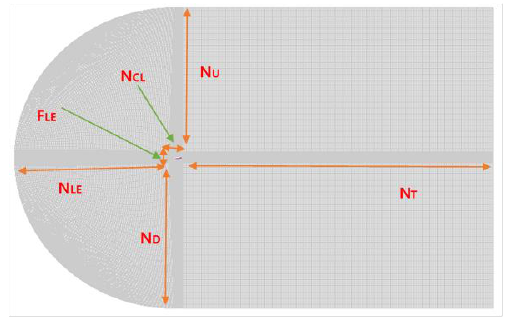
Figure 8. Mesh topology structure and its name. Table 4. Distribution of mesh in the computational domain for the mesh independence study.